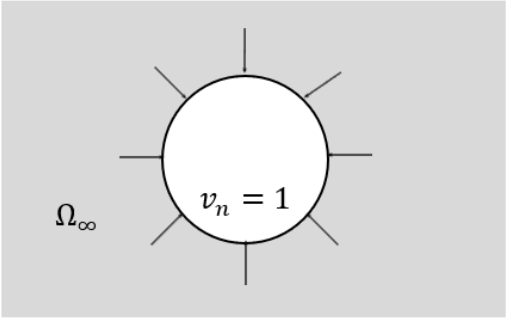
Figure 3. Schematic representation of the first test case, with a circular cavity subject to a unit particle velocity throughout its boundary.